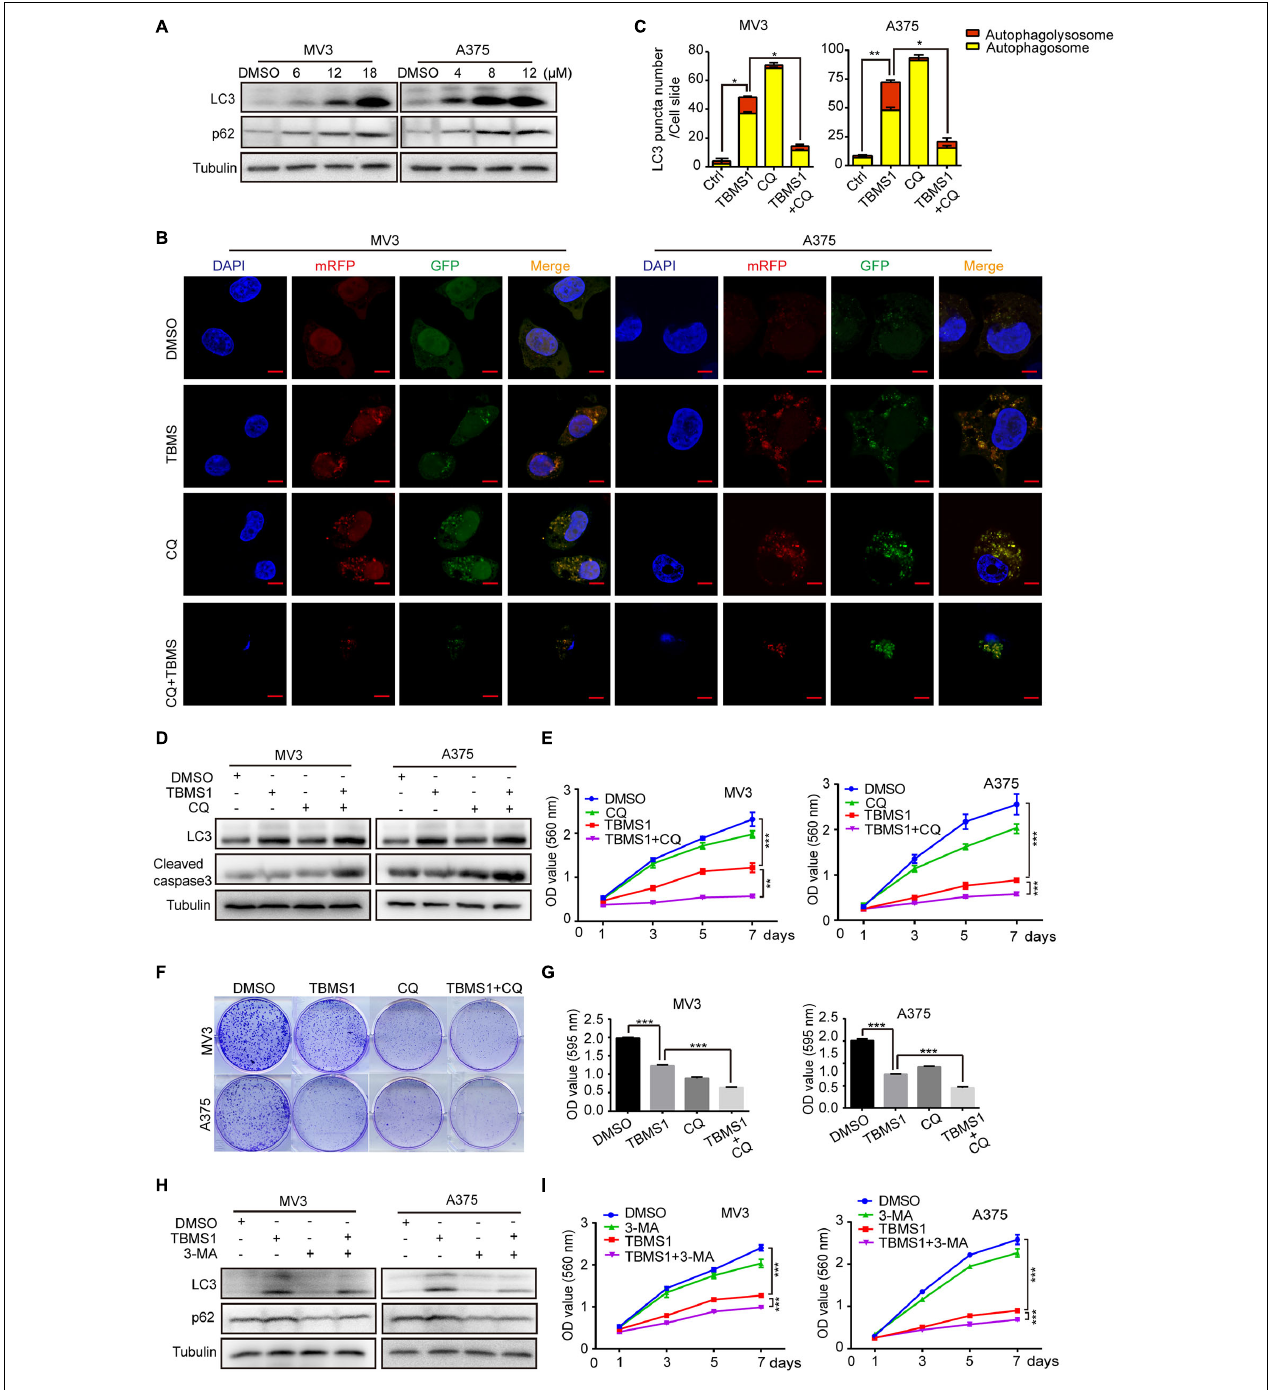
FIGURE 2 | TBMS1 induces a partly disrupted and cytoprotective autophagy in melanoma cells. (A) Western blot was performed to detect the expression levels of LC3B-II and p62 in melanoma cells treated with TBMS1 for 48 h. (B,C) After transfected with mRFP-GFP-LC3 plasmids, the level of autophagy was tested by immunofluorescence staining assay in MV3 and A375 cells treated with TBMS1 and 20 µ M CQ for 48 h. The yellow (autophagosomes) and red signals (autophagolysosome) in every cell per slide were calculated. (D) The expression levels of LC3B-II in melanoma cells treated with TBMS1 and 20 µ M CQ for 48 h. DMSO was used as control. (E) MTT assays were performed to detect cell viability in MV3 and A375 cells under the treatment of DMSO, TBMS1, 20 µ M CQ or combination. (F,G) Clonogenicity of MV3 and A375 cells treated with TBMS1 and 20 µ M CQ. The colonies formed after 10 days’ culture. The quantitative figure of clonogenic assay results. (H) The expression levels of LC3B-II in melanoma cells treated with TBMS1 and 2.5 µ M 3-MA for 48 h. DMSO was used as control. (I) MTT assays were performed to detect cell viability in MV3 and A375 cells under the treatment of DMSO, TBMS1, 2.5 µ M 3-MA or combination. A two-tailed unpaired Student’s t -test was carried out. * p < 0.05, ** p < 0.01, *** p < 0.001, **** p < 0.0001.